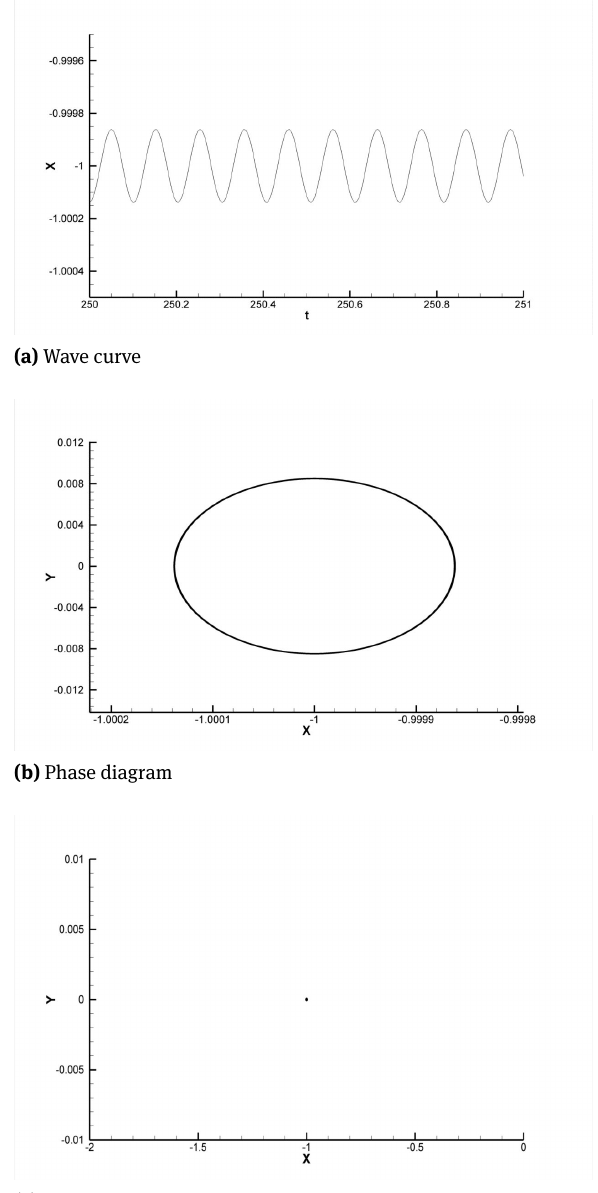
Figure 4: Periodic behavior of non-linear system ( r = 0.523, ω